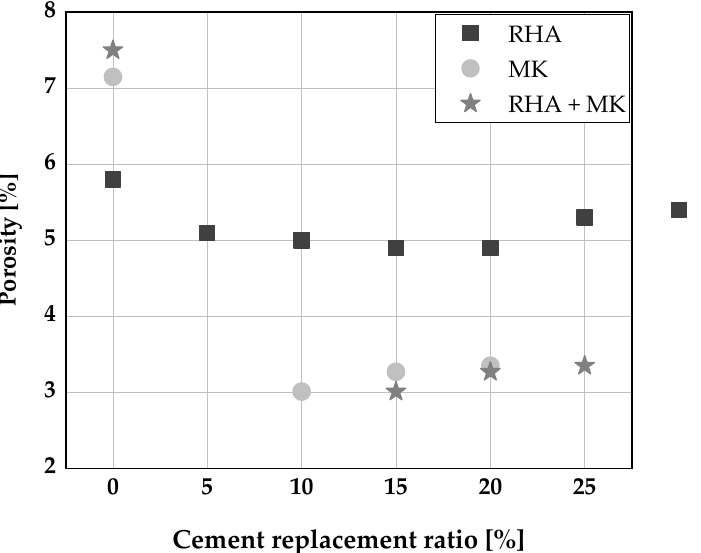
Figure 12. Porosity of SCC produced with RHA and MK: Chopra et al. [31], Barkat et al. [22], Gill [135].